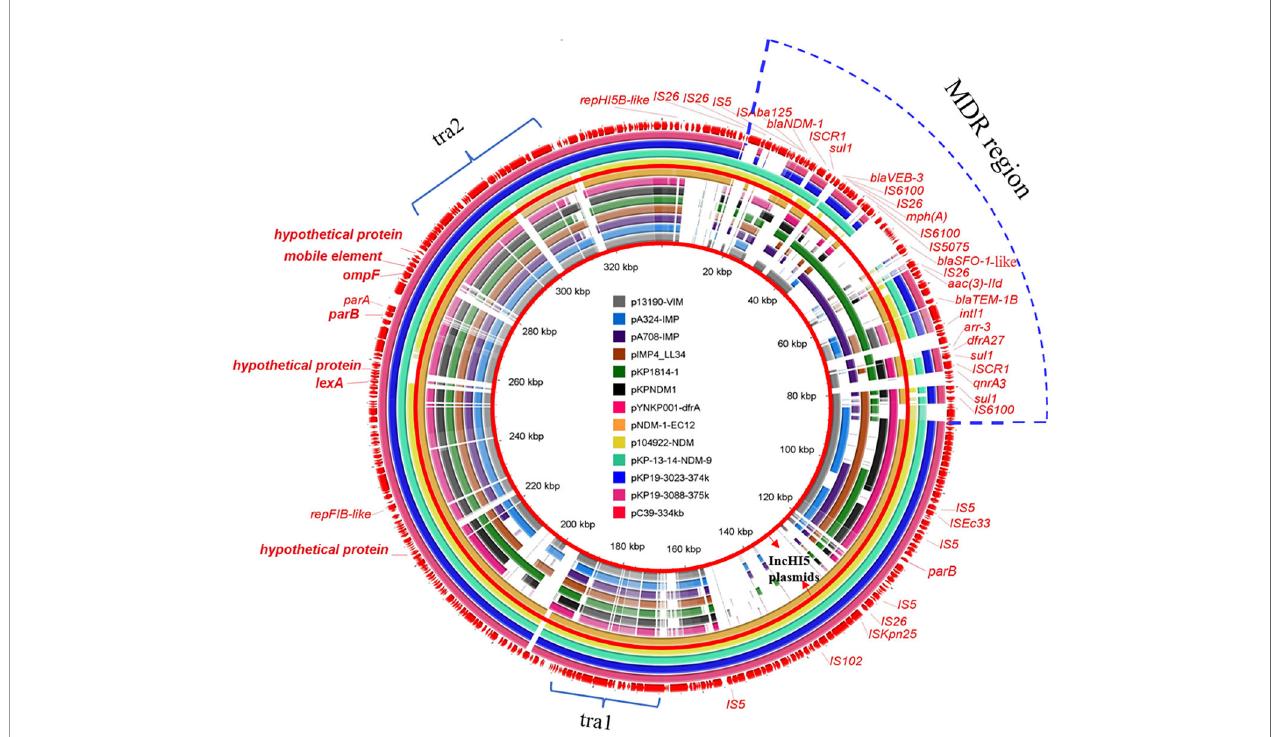
FIGURE 1 | Circular comparison of pC39-334kb and other similar plasmids in the NCBI database. The outermost circle with red arrows represents the reference plasmid pC39-334kb. IncHI5 plasmids are shown between red concentric circles, and the MDR region of pC39-334kb is marked by a blue dotted